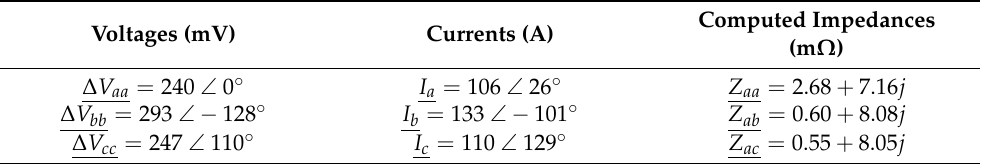
Table 6. Voltages and currents were obtained from the experimental method. The impedances were computed from